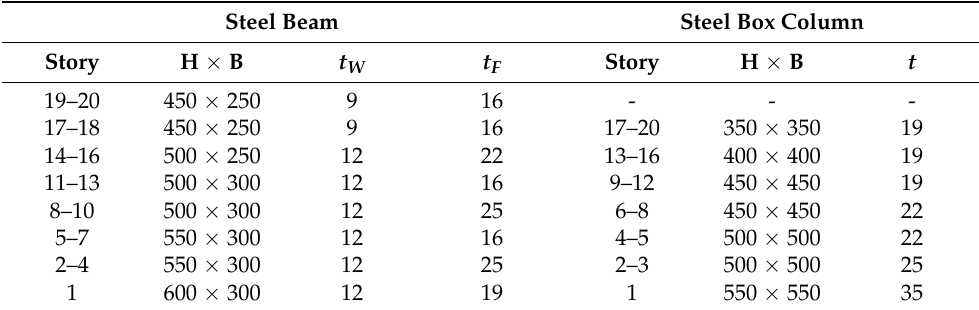
Table 1. Structural details of beam and column elements